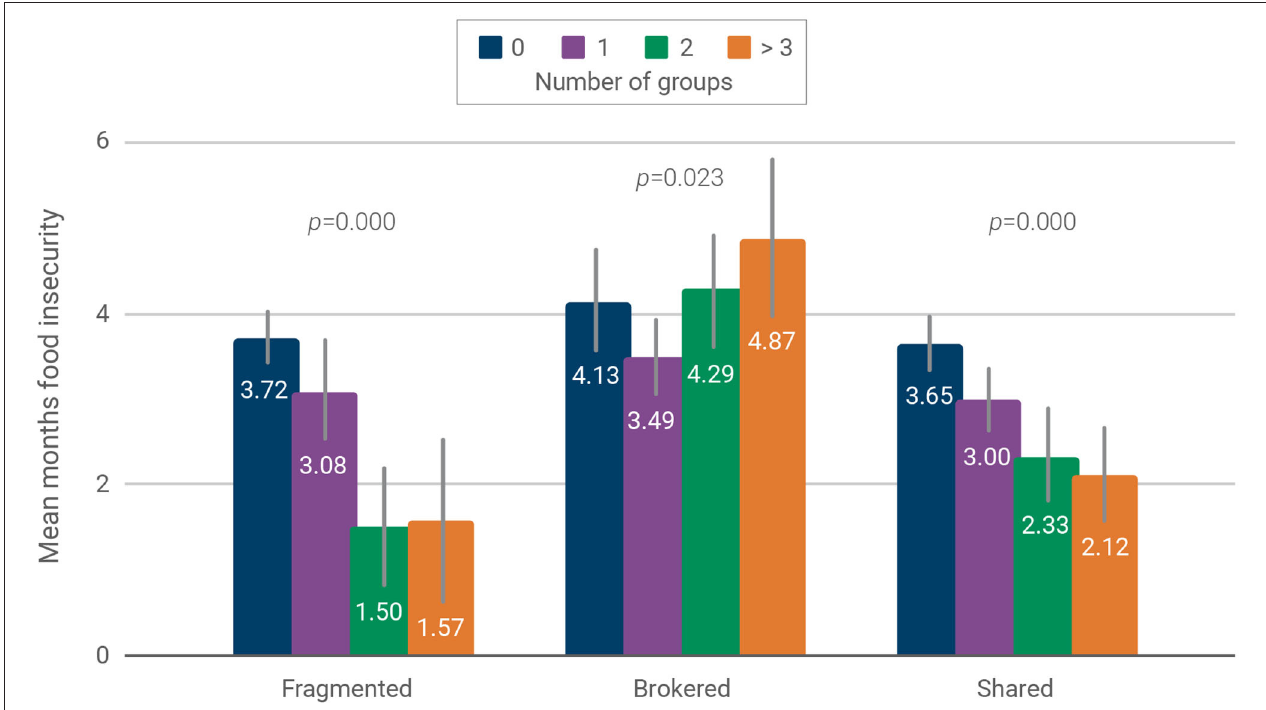
FIGURE 4 | Average months of food insecurity across household group membership by community network type. Lower numbers indicate reductions in food insecurity (i.e., greater food security